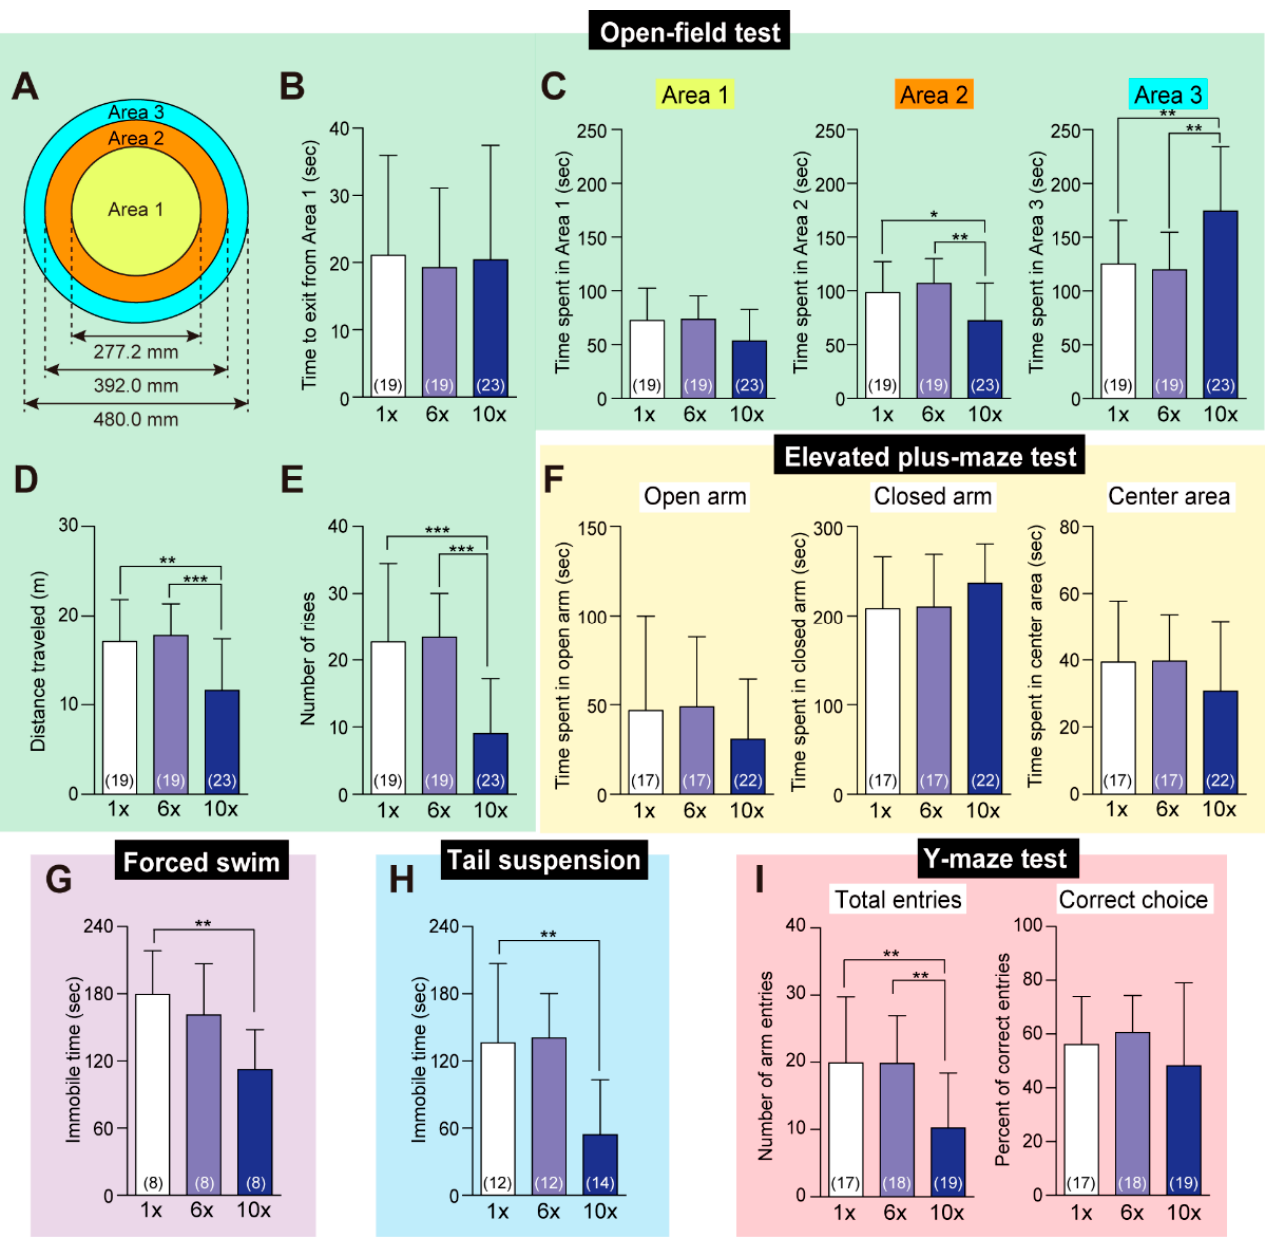
Figure 5. Behavioral assessments. Behavioral analyses were done on mice fed the control (1×Met), 6×Met, or 10×Met diet for a week. ( A – E ) Open-field test. Each mouse could roam the circular flat field with a side wall ( A ) consisting of Areas 1–3 (equal dimensions) for 5 min. Time to exit Area 1 ( B ), retention times in each area ( C ), distance traveled ( D ), and the number of rises ( E ) were measured. ( F ) Elevated plus-maze test. Retention times in the open arm, closed arm, and the center area was measured in the 5-min test. ( G ) Forced swim test. Each mouse was forced to swim for 7 min and the immobility time was recorded. ( H ) Tail suspension test. Each mouse was suspended by its tail for 6 min and the immobility time was recorded. ( I ) Y-maze test. Each mouse could roam the Y-maze apparatus for 5 min, and total arm entry times and percentages of correct arm choices were counted. Data are the mean ± SD ( n in parentheses). The differences versus 1×Met or 6×Met samples were significant at * p < 0.05, ** p < 0.01, and *** p < 0.001 in the Student’s t -test.